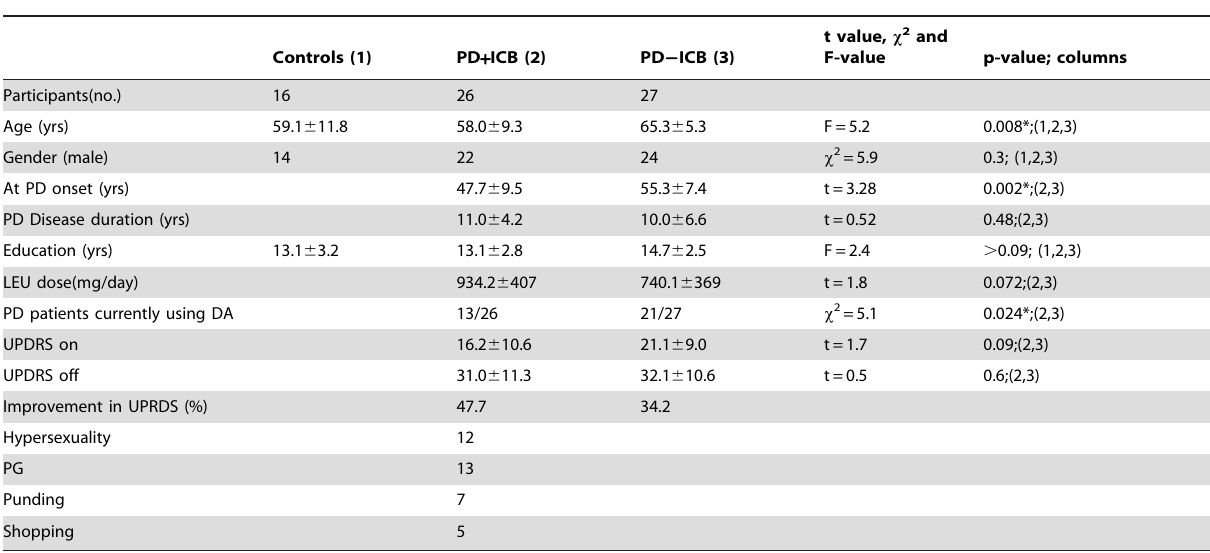
Table 1. Demographic